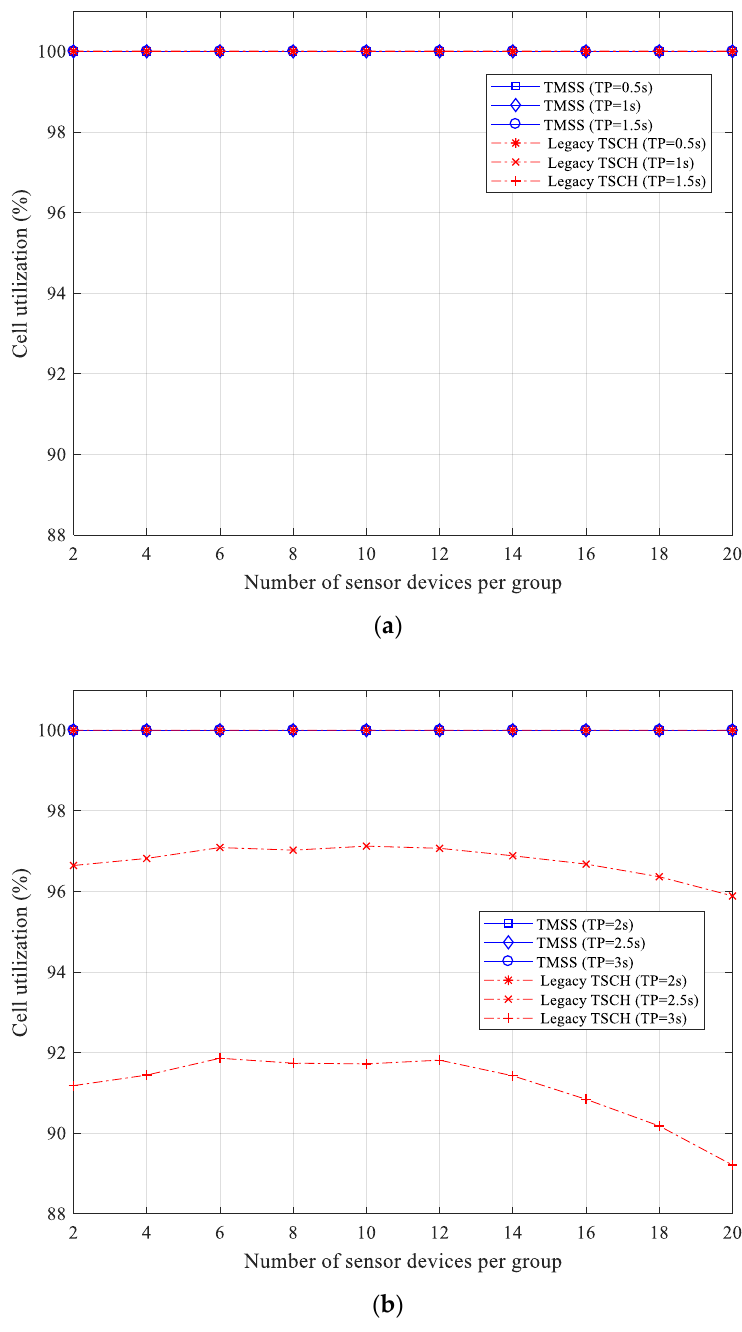
Figure 10. Cell utilization: ( a ) short TP scenario; ( b ) long TP scenario.